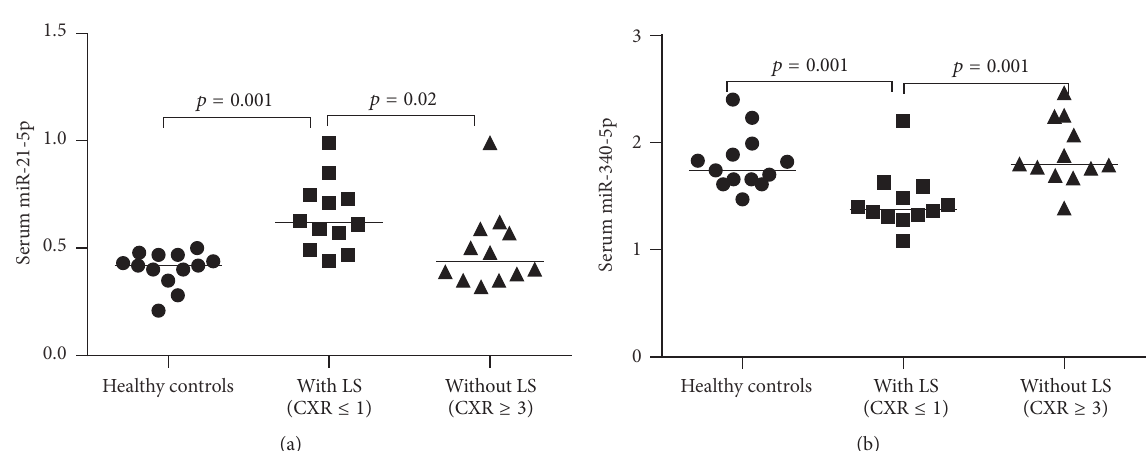
Figure 3: Serum miRNAs only dysregulated in our sarcoidosis patients with L¨ofgren’s syndrome compared to healthy controls. CXR, chest X-ray and LS, L ¨ ofgren’s